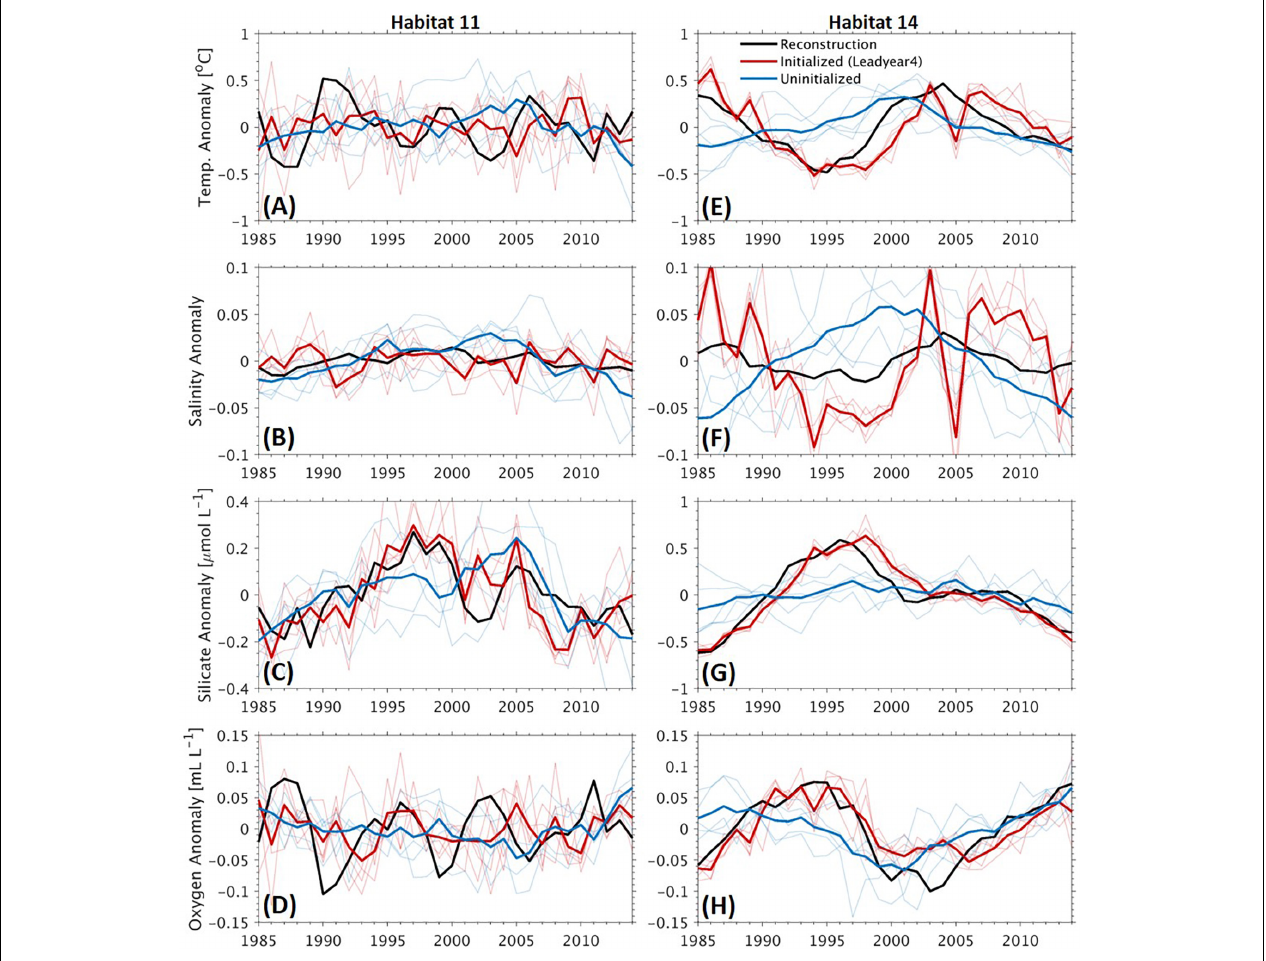
FIGURE 7 | Time series of detrended anomalies of annual mean temperature (A,E) , salinity (B,F) , concentrations of silicate (C,G) , and oxygen (D,H) at sponge habitats 11 (A–D) and 14 (E–H) . Bold black lines: reconstruction, bold red/blue lines: ensemble means of the initialized/uninitialized simulations at a lead time of 4 years, thin red/blue lines: individual members of the initialized/uninitialized simulations. The locations of the two habitats can be seen in Figure 1